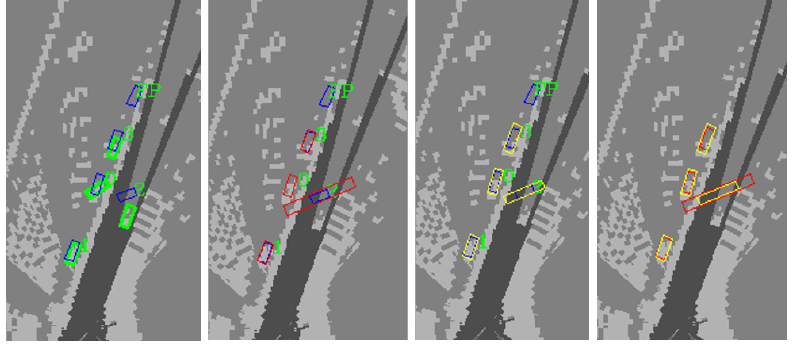
Figure 12. Spatial uncertainty based on deep